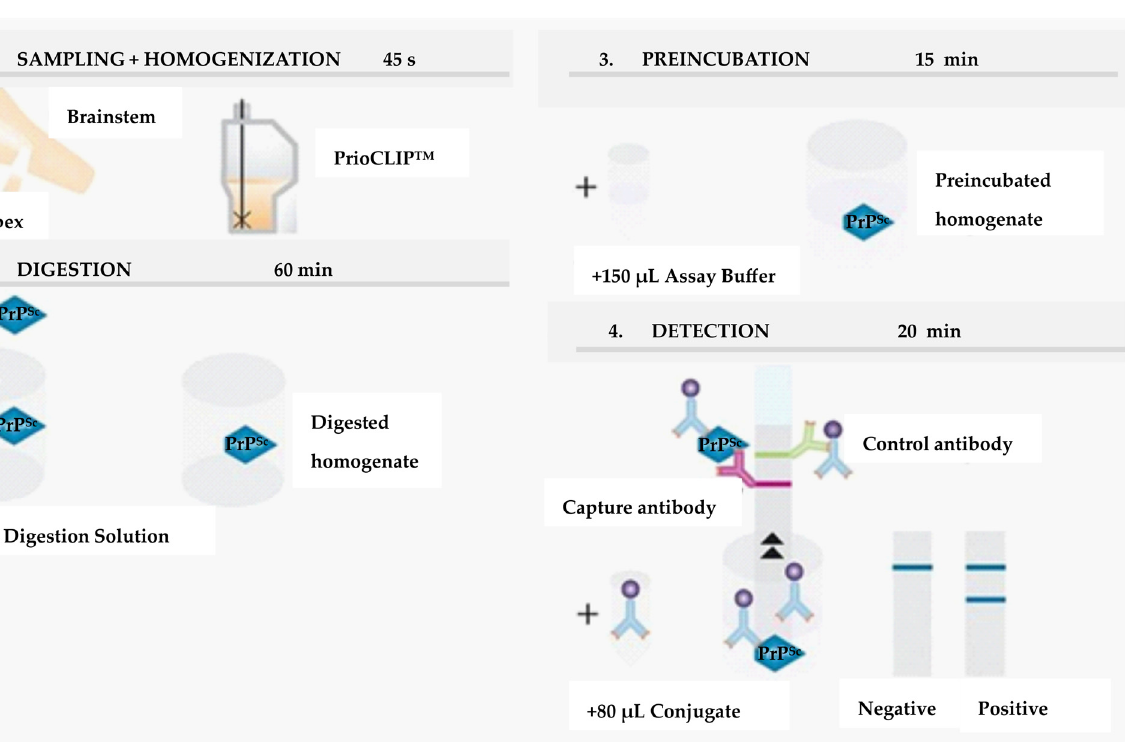
Figure 6. Principle of Prionics ® -Check PrioSTRIP test. Adapted from Ref.